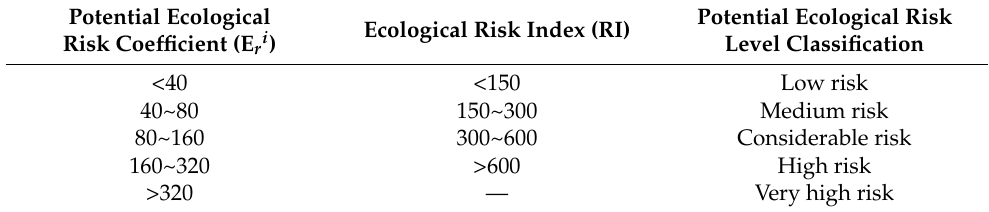
Table 1. Classification of potential ecological risk coefficient (E ri ) and ecological risk index (RI) of heavy